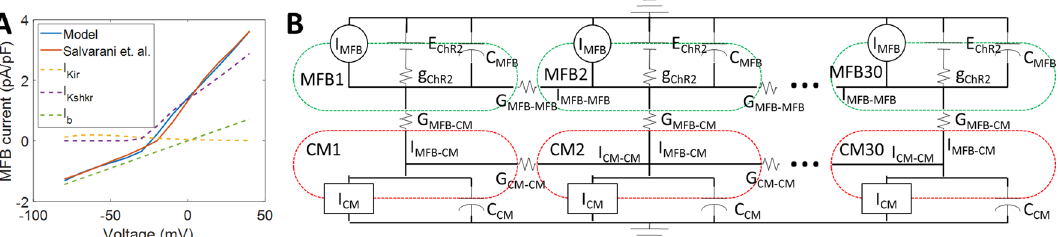
Figure 5. Computational model. ( A ) Endogenous cardiac MFB currents were modeled by adjusting the current conductances in the Sachse et al. fibroblast model 34 to match the current–voltage relationship found by Salvarani et al. 13 for TGF-β1-treated MFBs. The dashed lines show the contributions of individual currents. ( B ) The ChR2 channel model ( g ChR2 , E ChR2 ) from Williams et al. 33 was added to endogenous MFB currents ( I MFB in figure, I MFB,endo in equations). MFBs were electrically connected ( G MFB-CM ) to neonatal rat cardiomyocytes (CMs) as modeled by Korhonen et al. 17 which were connected to each other ( G CM-CM ) to form a 30-cell, 1.5 mm 1-D cable. MFBs were only connected to each other ( G MFB-MFB = G CM-CM ) in Supplementary Fig. 5, otherwise G MFB-MFB = 0. Dashed lines show outer boundaries of CMs (red) and MFBs (green). Formulas for variables and values for parameters are listed in Supplementary Tables